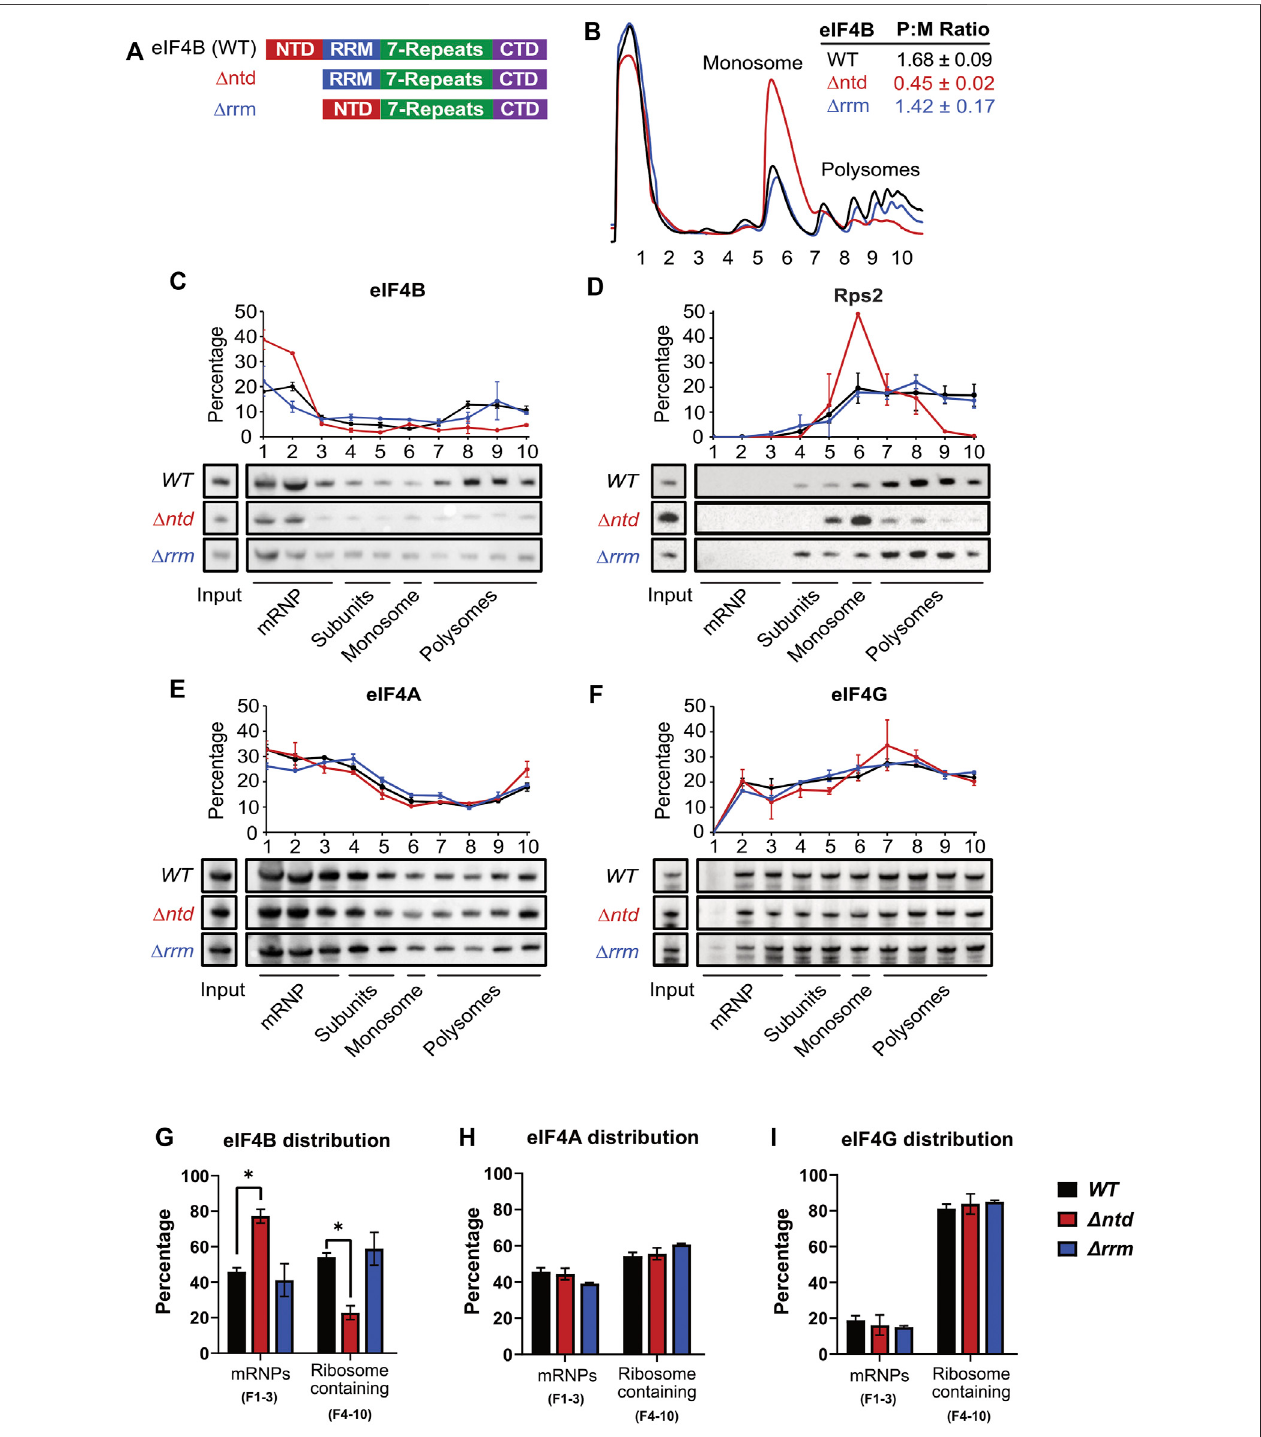
FIGURE 1| The N-terminal domain of eIF4B binds the ribosome and promotes translation in a prototrophic yeast strain. (A) Schematic of eIF4B functional domains in WT, Δ ntd, and Δ rrm constructs. (B) Lysates from strains harboring WT (black), Δ ntd (red), or Δ rrm (blue) eIF4B were fractionated on 5 – 45% sucrose gradients and monitored by absorbance at 254 nm. Polysome to monosome (P:M) ratios were calculated by quantifying the area under the curve for the indicated monosome and polysome peaks. The Mean P:M ratios from three or more biological replicates (representative traces shown) are reported ± standard error of the mean. (C – F) Lysates were crosslinked with 1% formaldehyde prior to running on 5 – 45% sucrose gradients. The distributions of eIF4B (C) , Rps2 ( D , an indicator of 40S subunits/monosomes/polysomes), eIF4A (E) , and eIF4G (F) in mRNP, subunit, monosome, and polysome fractions were determined by western blotting indicated gradient fractions. The line graphs show the mean percentages of total indicated protein (quanti fi ed across the gradient) that was present in each fraction. (G – I) The distributions of eIF4B (G) , eIF4A (H) and eIF4G (I) in mRNP vs. ribosome containing fractions were analyzed by an unpaired students t test. The only signi fi cant differences observed were for Δ ntd versus WT eIF4B distributions. Asterisk indicates p value ≤ 0.05.